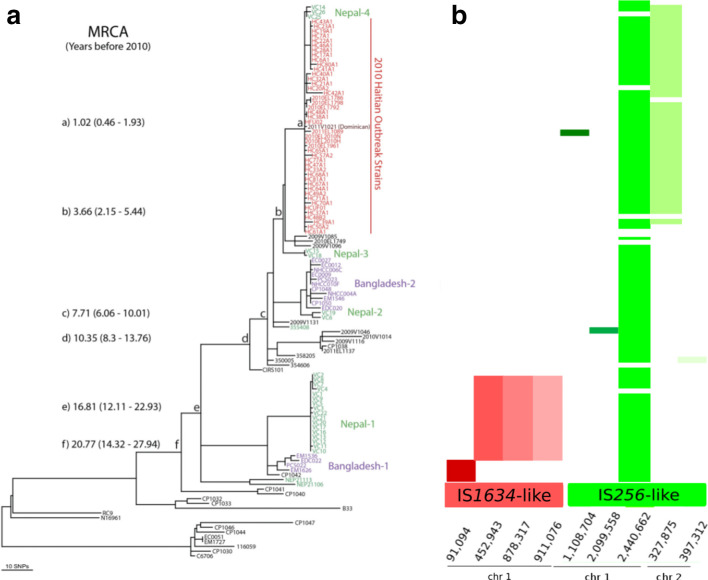
Comparison of (a) phylogenetic analysis from Eppinger et al. [9] and (b) IS-related events identified by panISa. Red boxes represent insertions of IS1634-like elements and green boxes represent insertions of IS256-like elements. Each column represents an insertion site on a specific chromosome. The two colours refer to the two different ISs detected in the dataset, and the different shades of colours represent the different positions of insertion of each IS [at the chromosomal positions indicated at the bottom of (b)].